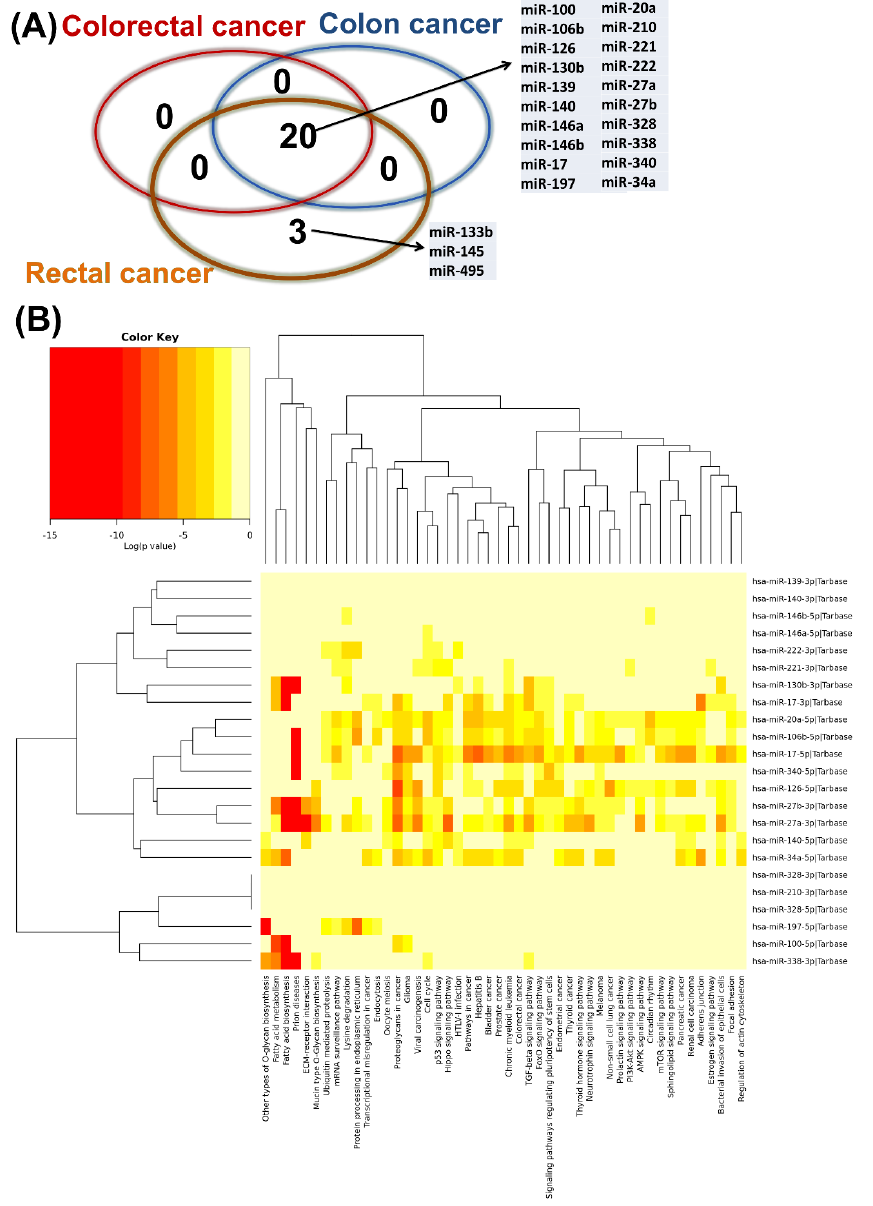
Figure 7. Plasma miRNAs as key modulators of drug resistance, with altered expression in colon and rectal cancer, as well as for the global analysis comprising all colorectal cancers. ( A ) Venn diagram for the altered miRNAs which supposedly interfere with drug resistance in the analyzed groups; ( B ) heatmap generated using DIANA-miRPath v3.0, showing miRNA targets associated with biological processes related to the common miRNA signatures involved in drug resistance. In the analysis for colorectal and rectal cancer chemo-treated versus untreated, we identified a panel of seven miRNAs as modulators of drug resistance mechanisms (Figure 8A). Figure 8B presents the implication of miRNA in key biological processes. The miRnet network for common miRNA signatures emphasized an important number of target genes related to pathways in cancer